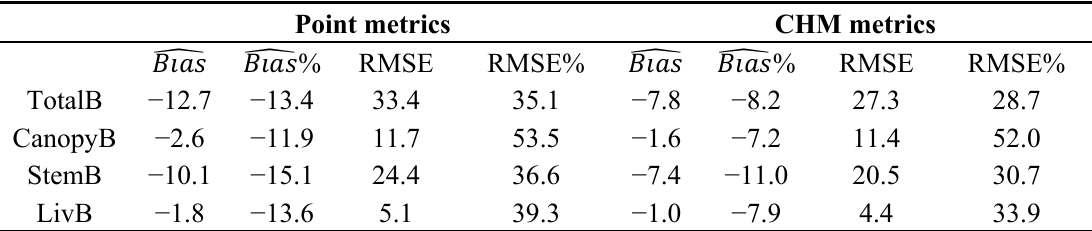
Table 2. Results calculated in trial 1: Training set = Optech-plots; Test set = Leica-plots. Point metrics